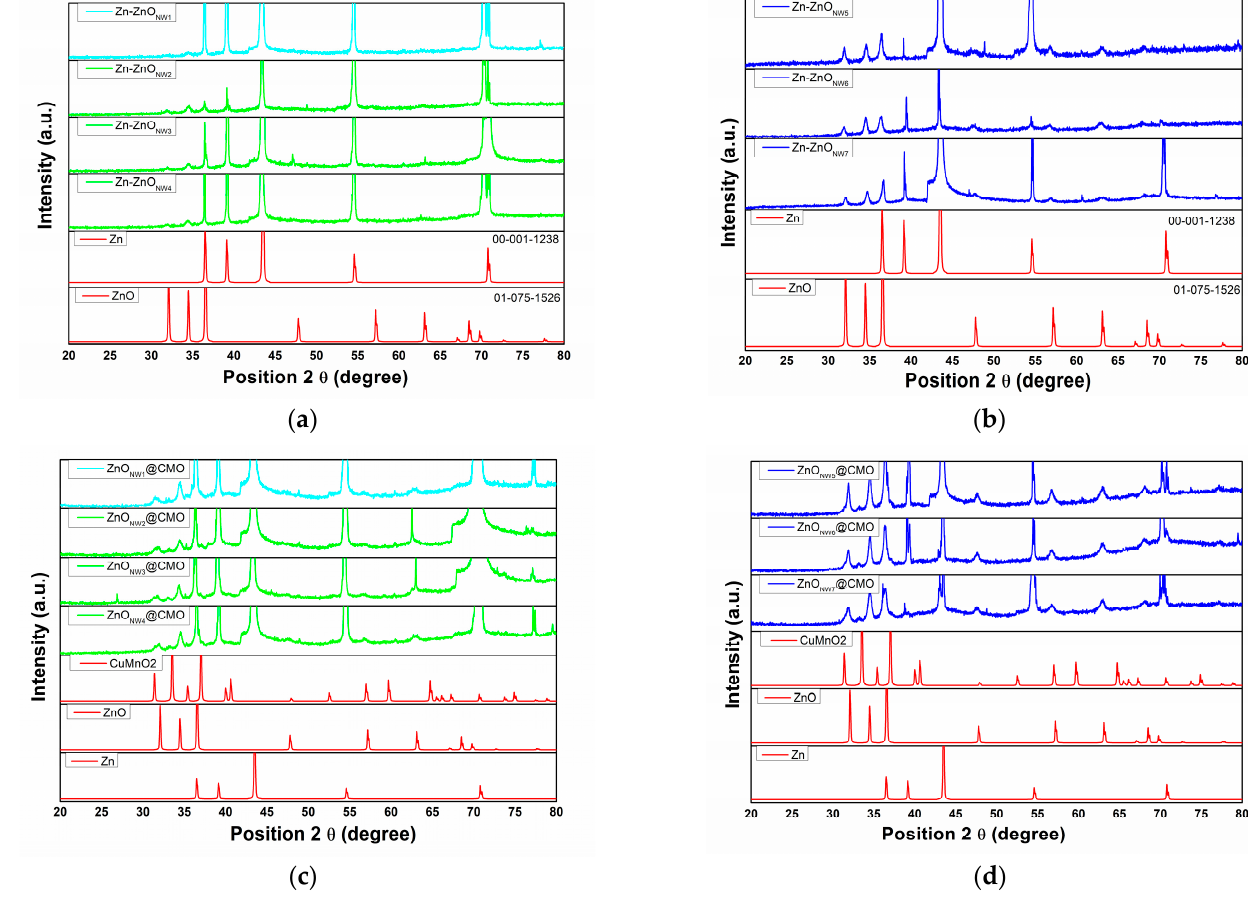
Figure 3. X-ray patterns for Zn- ZnO Nw layers ( a , b ) and as-obtained ZnO Nw @CMO sensors ( c , d ).